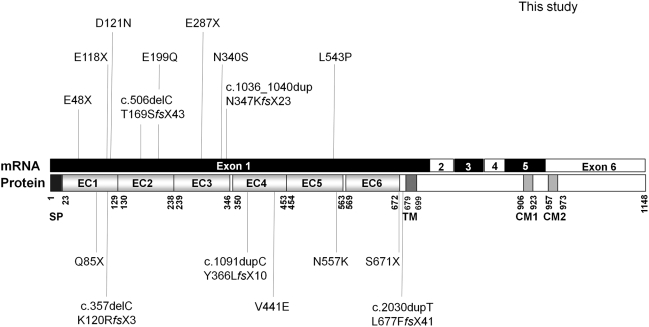
Schematic representation of the point mutations identified in the PCDH19 gene.Above: mutations identified in this study; Below: mutations identified by Dibbens et al. (2008). SP: signal peptide; EC: extracellular cadherin domain; TM: transmembrane domain; CM1 and CM2: cytoplasmic domains 1 and 2.